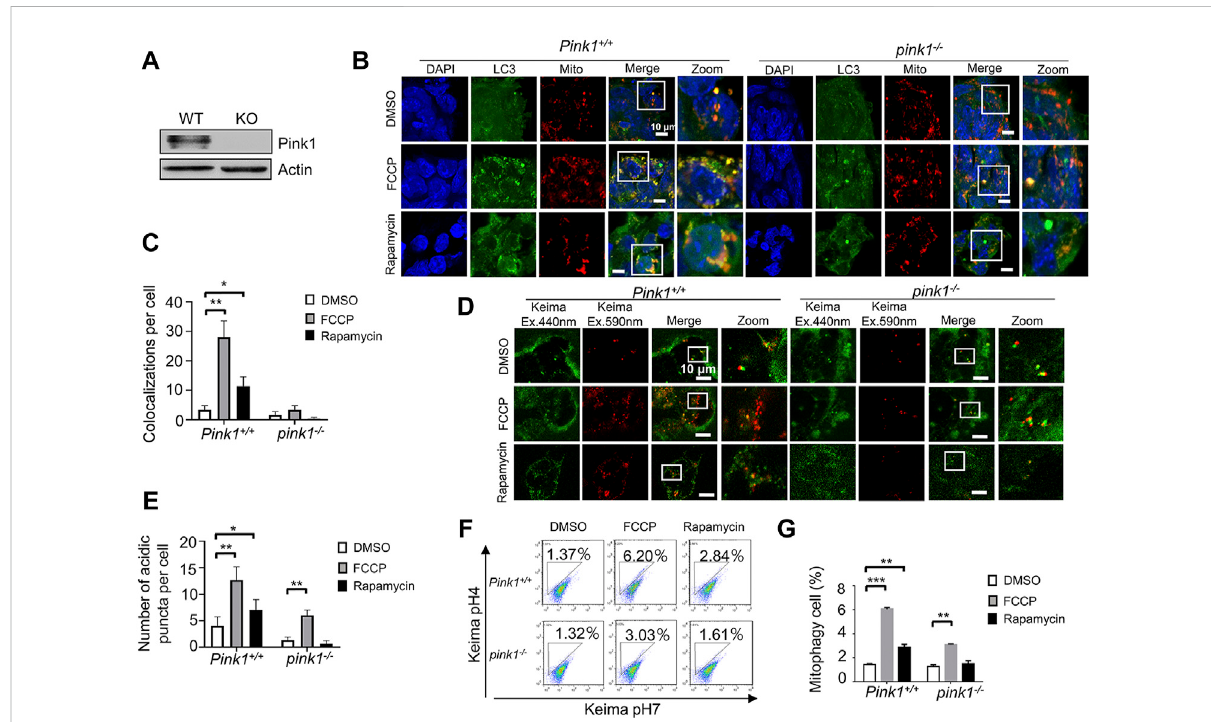
FIGURE 4 Detecting mitophagy in Pink1 knockout ESCs by the two fl uorescence-based imaging systems. (A) , Western blot of Pink1 wild-type and knockout ESCs. (B) , Monitoring mitophagy in Pink1 wild-type and knockout ESCs by the EGFP-LC3 system. After FCCP or rapamycin treatment, the co-localizations of LC3 and mitochondria clearly increased in wild-type ESCs, but not in knockout ESCs. Green: LC3; red: mitochondria; blue: DAPI. (C) , Quanti fi cation of mitophagy in (B) . Co-localizations of LC3 and mitochondria were counted in 200 cells from 3 independent experiments. Data are shown as mean ± SD, n = 3; * p < 0.05, ** p < 0.01, Student ’ s t-test. (D) , Monitoring mitophagy by the mt-Keima system. More mitophagy puncta were observed in both Pink1 wild-type and knockout ESCs following FCCP treatment. (E) , Quanti fi cation of mitophagy in (D) . Red puncta werecountedin200cellsfrom3independentexperiments.Dataareshownasmean±SD, n =3;* p < 0.05,** p < 0.01,Student ’ st-test. (F) ,Evaluation ofmitophagyinPink1wild-typeandknockoutESCsbyaFACS. (G) ,Quanti fi cationsofmitophagycellin (F) .Dataareshownasmean±SD, n =3;** p < 0.01, *** p < 0.001, Student ’ s